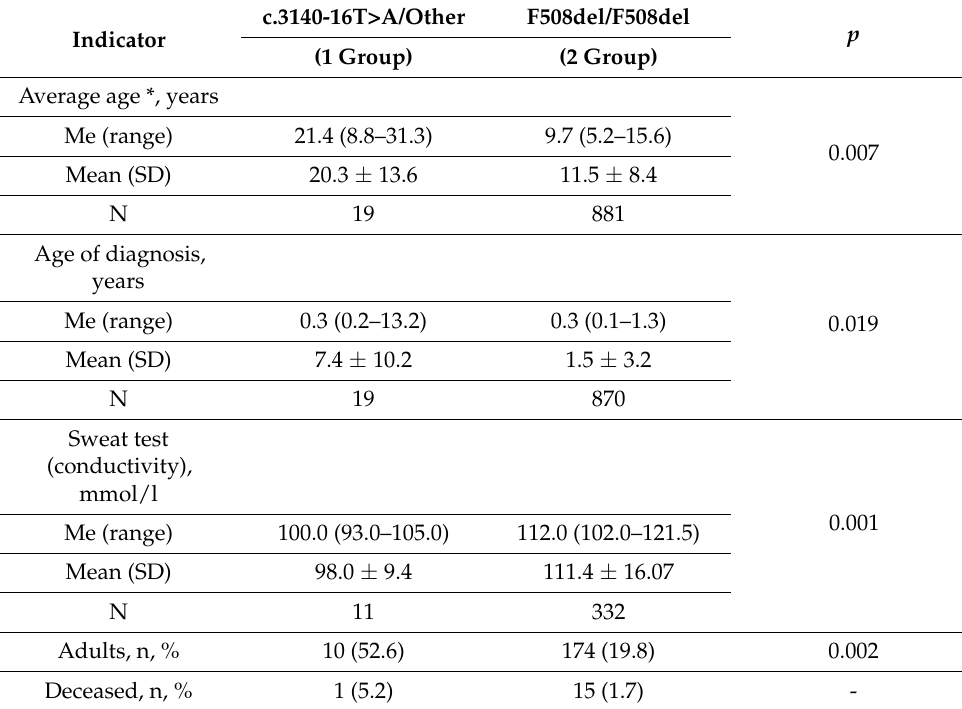
Table 1. General characteristics of patients with the studied genotypes.